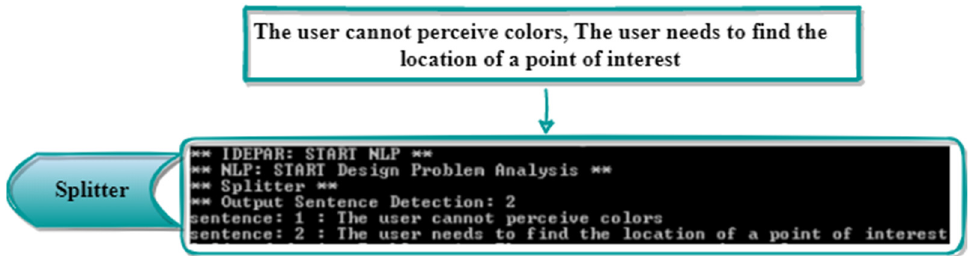
Figure 8. Splitter results for DPS-1.